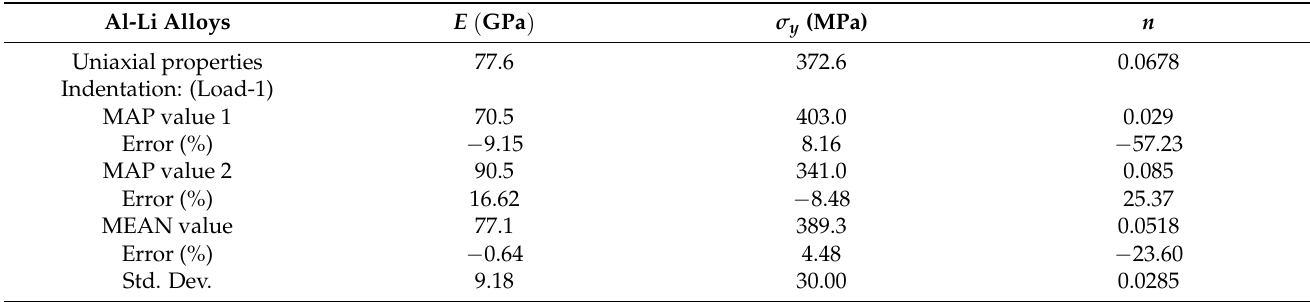
Table 2. Comparison of the identified MAP, MEAN values of elastoplastic properties using the imprint snapshot under indentation Load-1.